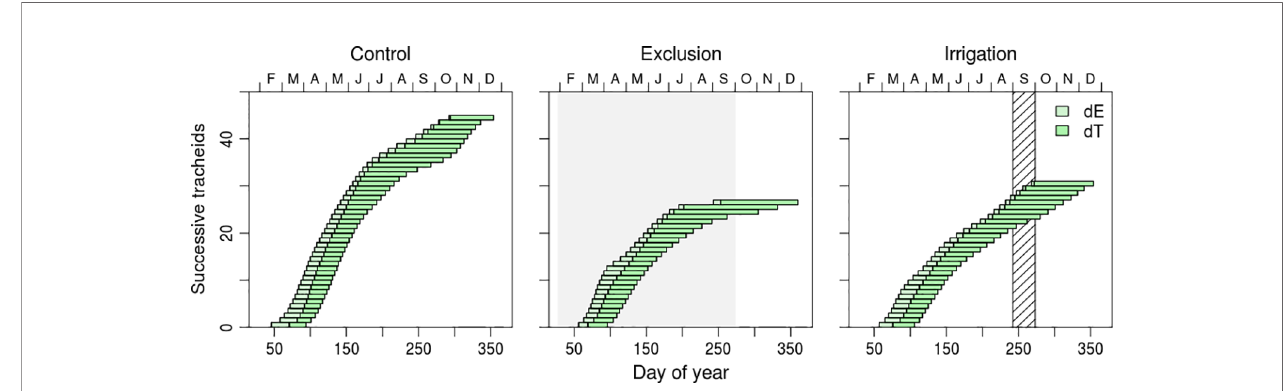
FIGURE 4 | Residence time of each tracheid in enlargement (dE; light green horizontal bars) and cell wall deposition (dT; dark green horizontal bars), during the growing season of 2017. Each bar represents a tracheid. Gray shaded area corresponds to the rain exclusion period and diagonal line area to the irrigation period.